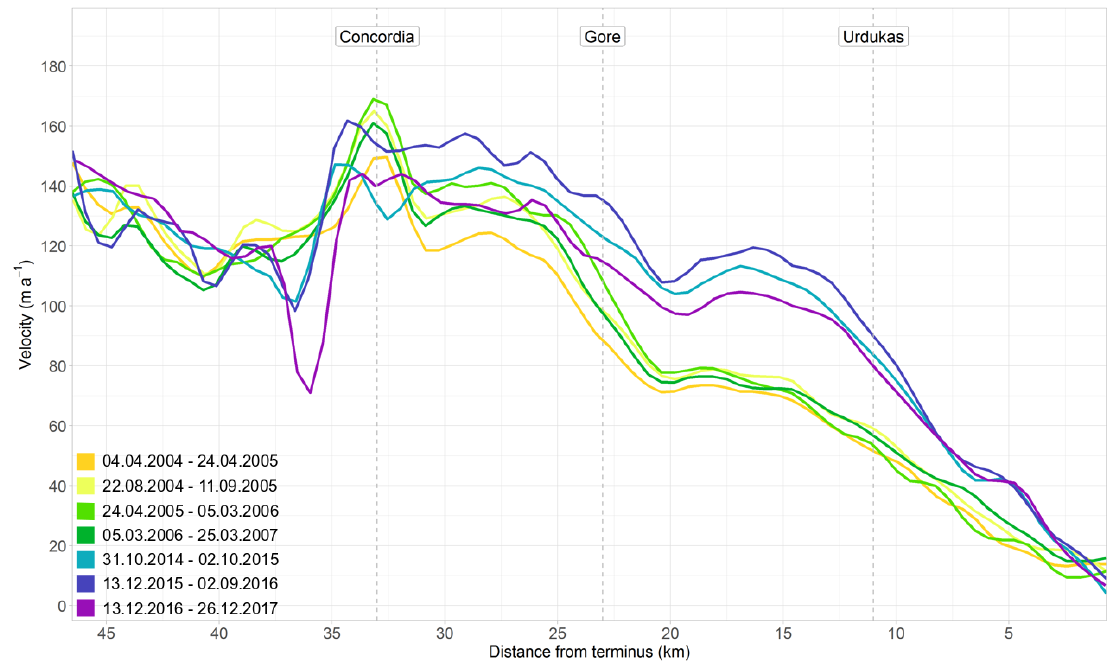
Figure 2. Annual surface velocities (m a − 1 ) along the glacier